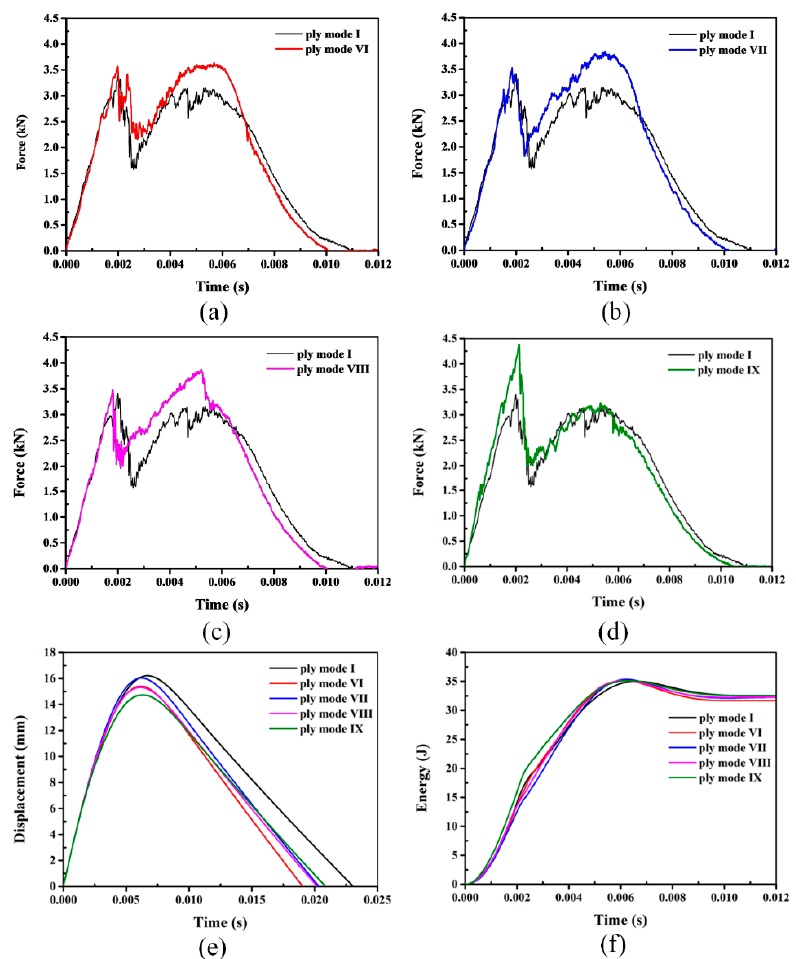
Figure 10. Typical impact responses of hybrid sandwich panels with two layers of SMA wires. ( a–d ) represent the force-time curves of mode I with modes VI, mode VII, mode VIII and mode IX, respectively; ( e , f ) show the displacement-time and energy-time histories, respectively. Table 4. Impact responses of the sandwich panels without or with two layers of SMA wires.